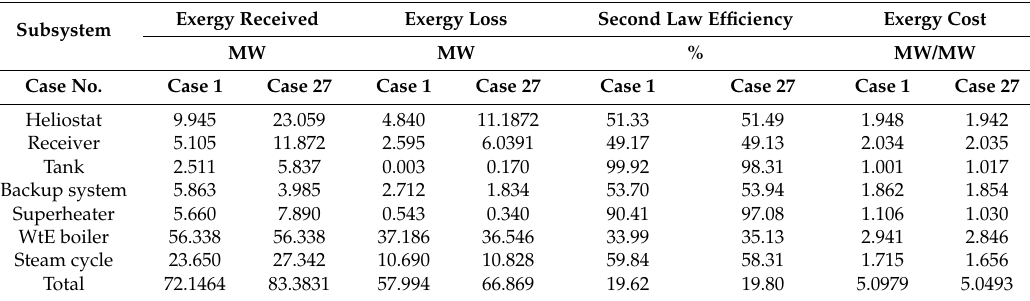
Table 3. Exemplary results of the exergy analysis for the solar subsystem (case 1 and